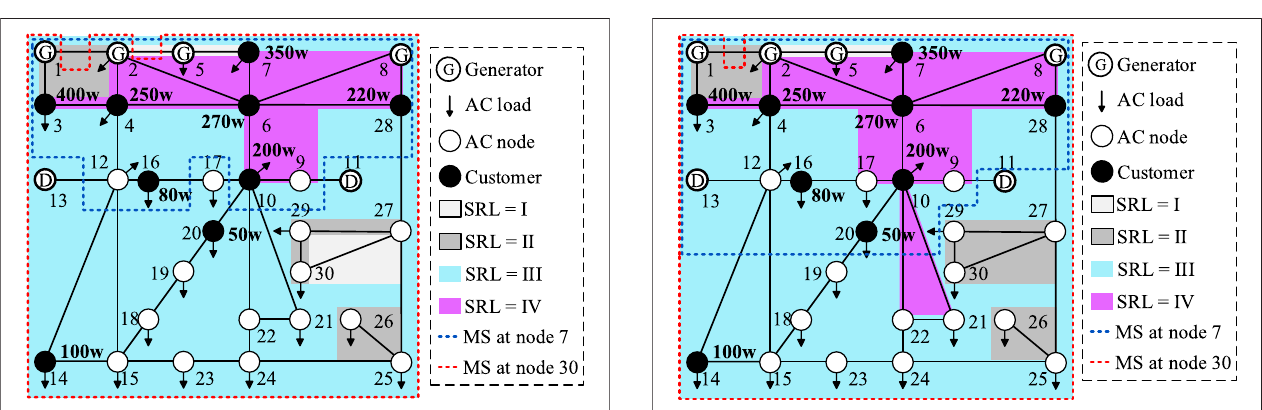
FIGURE 8 | Monitoring scope of case B2. FIGURE 9 | Monitoring scope of case